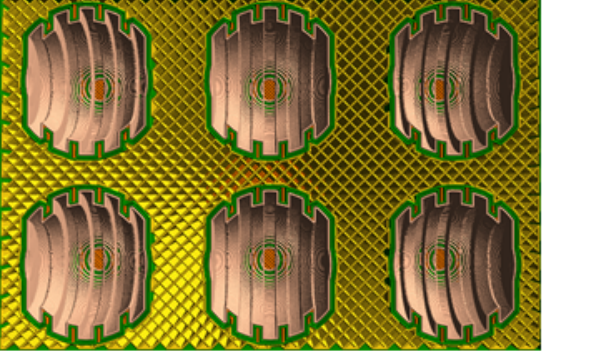
Figure 1. Top and cross-section views (left and right columns, respectively) of ABS 3DP molds featuring different shapes and geometries ( A ) and example of sliced perspective of 3DP mold ( B ).